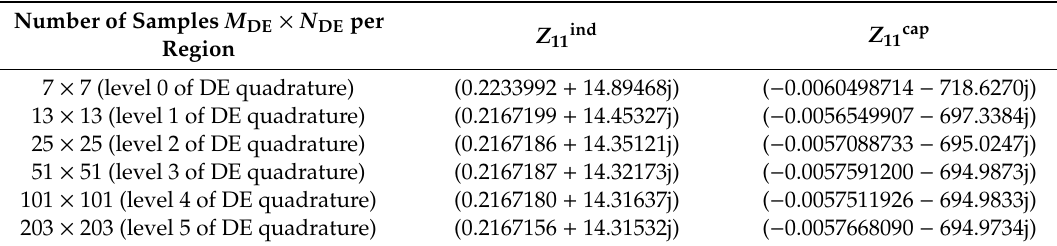
Table 2. Convergence pattern with respect to the number of DE samples per region of the inductive, Z 11ind , and capacitive, Z 11cap , contributions of the MoM coe ffi cient matrix. Number of Samples M DE × N DE